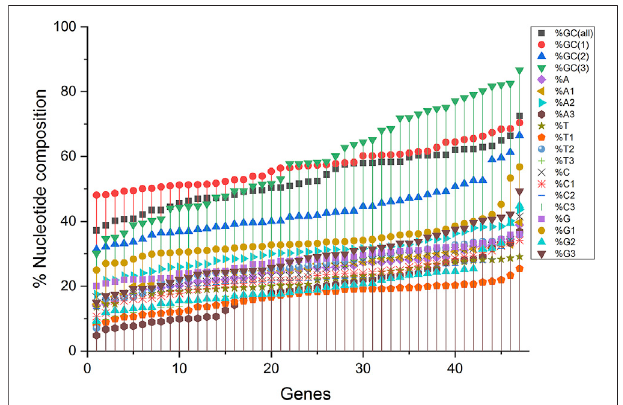
FIGURE 1 | A nucleotide compositional analysis fi gure shows the trend of the compositional constraints. The nucleotide contents are sorted here as per their increasing values and do not depict their content in a single